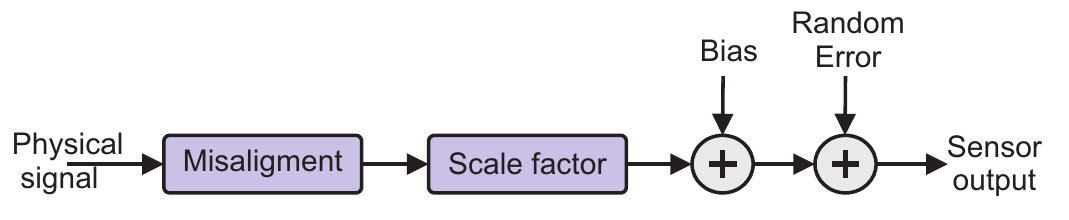
Figure 2. Inertial sensor error modeling; figure kindly taken from